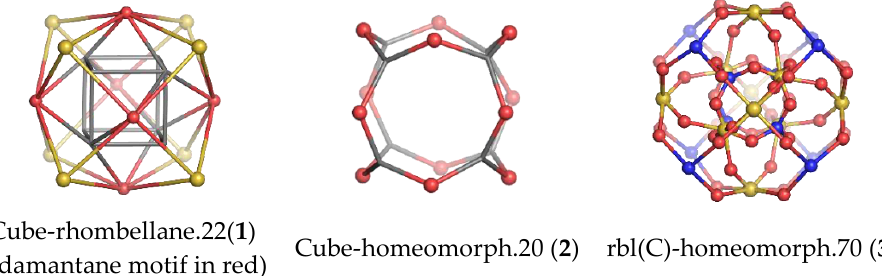
Figure 1. Cube-rhombellane and its related homeomorphs.